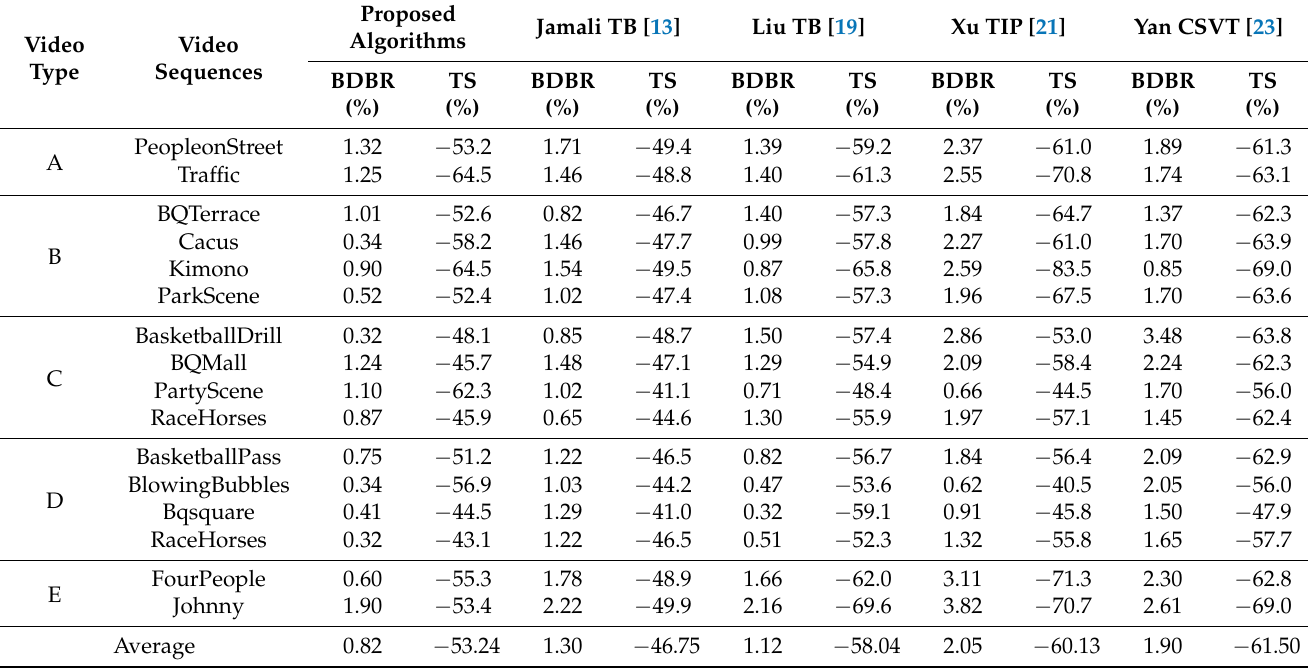
Table 6. Results of the proposed algorithm compared with a state-of-the-art fast